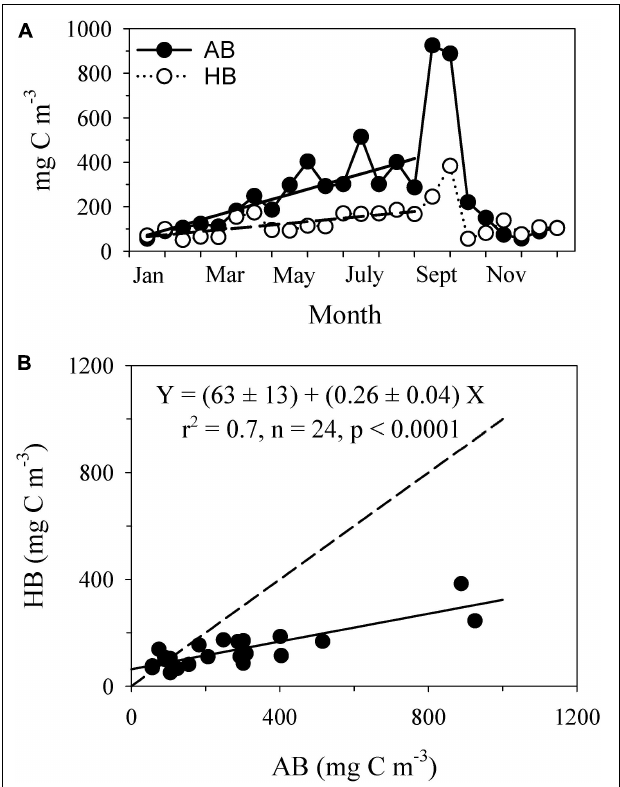
FIGURE 4 | Time series of (A) total autotrophic biomass (AB) and total heterotrophic biomass (HB) of microbial plankton and (B) the relationship between the total AB and total HB of microbial plankton. In (A) the continuous line shows the seasonal increase of AB, Y = (48 ± 38) + (23 ± 4)X; r 2 = 0.71; n = 16; p < 0.001. Dashed line illustrates the seasonal increase of HB, Y = (57 ± 16) + (8 ± 2)X; r 2 = 0.59; n = 16; p < 0.001. In (B) the dashed line denotates the 1:1 relationship. The values were averaged every half-month ( n = 3–5) to remove short-term variability.